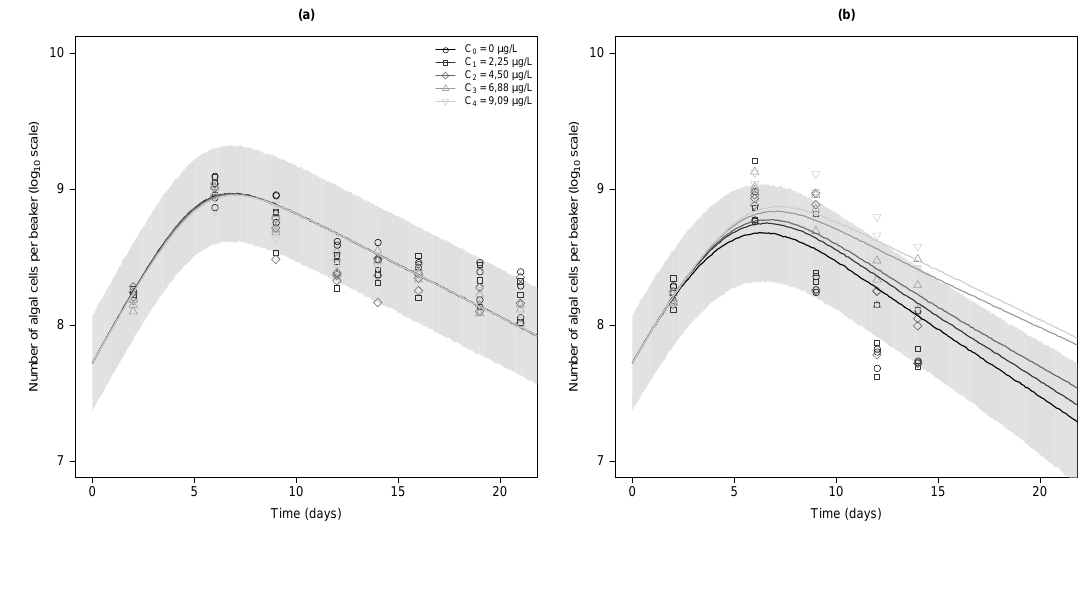
Figure 2. Model fitting for state variables related to algae dynamics: (a) with duckweeds; (b) with duckweeds and daphnids. Symbols refer to the different tested cadmium concentrations of Experiment 5. Plain lines stand for the fitted model with each parameter equal to its median value at each concentration C j . The light grey area corresponds to the 95% credible band of the predicted data in the